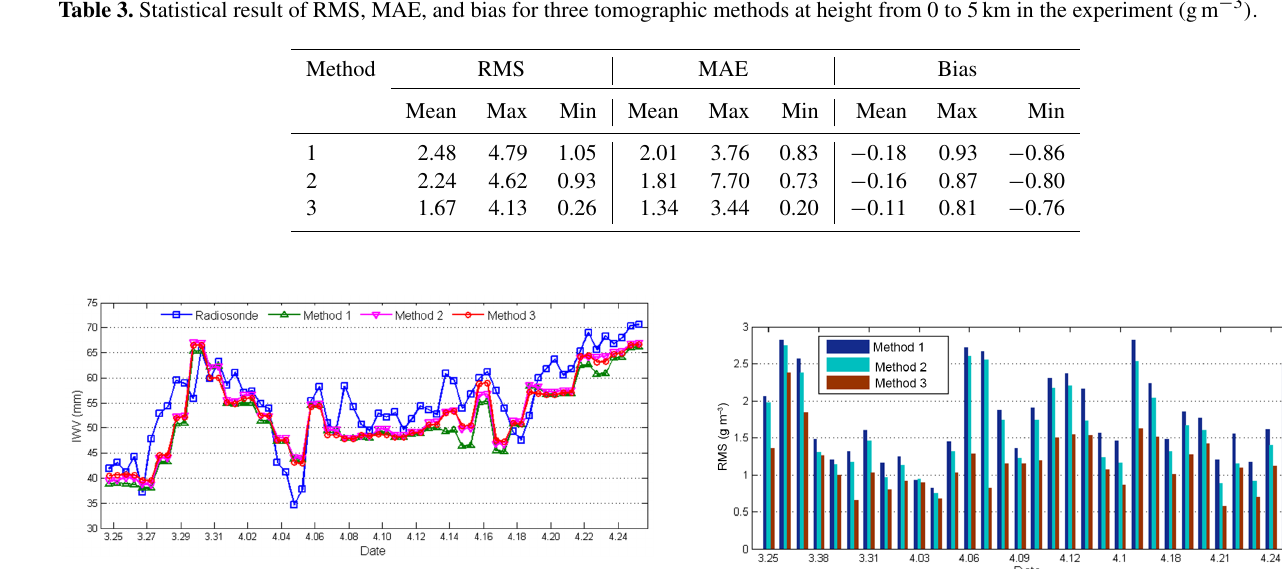
Figure 10. Histogram of RMS error for different tomographic areas in the experiment.